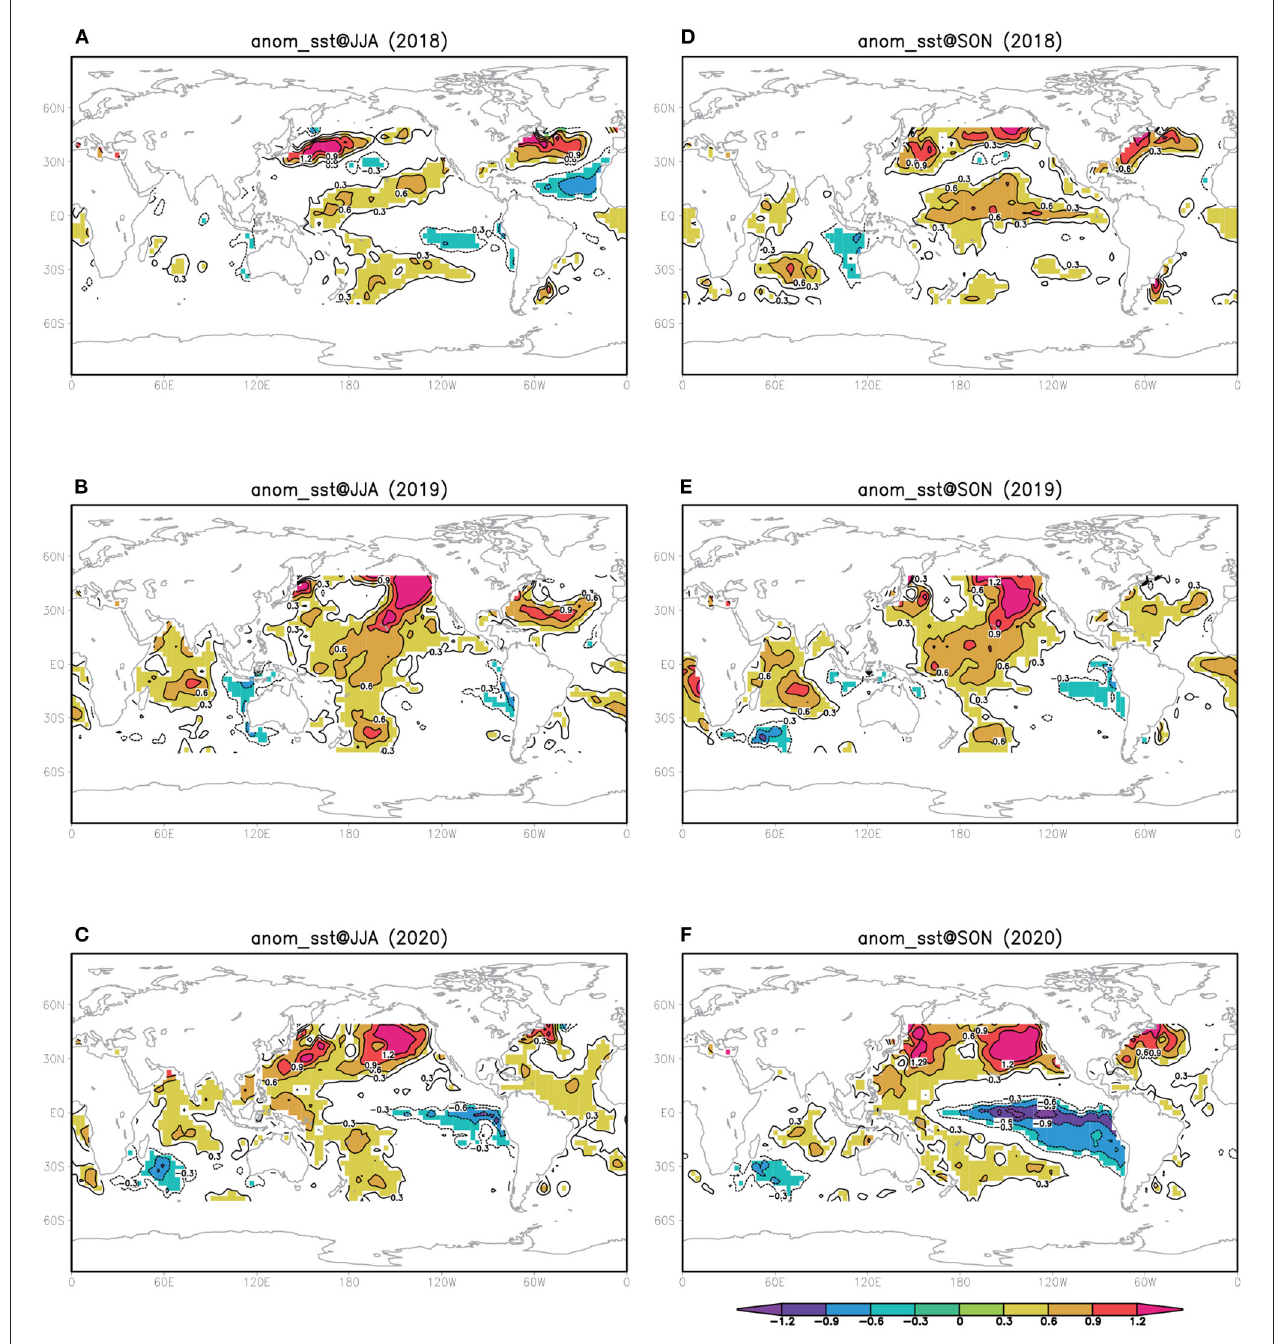
FIGURE 6 | Spatial patterns of the observed SST (units; ◦ C) anomalies in (A–C) JJA and (D–F) SON. Regions exceeding ± 0.3 ◦ C are